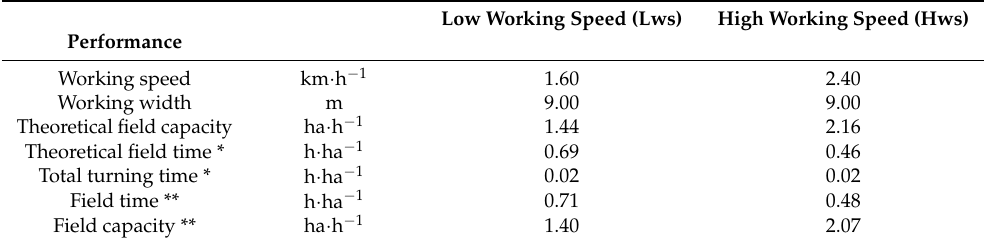
Table 7. Estimated field capacity of the mowers with the two different working speeds.